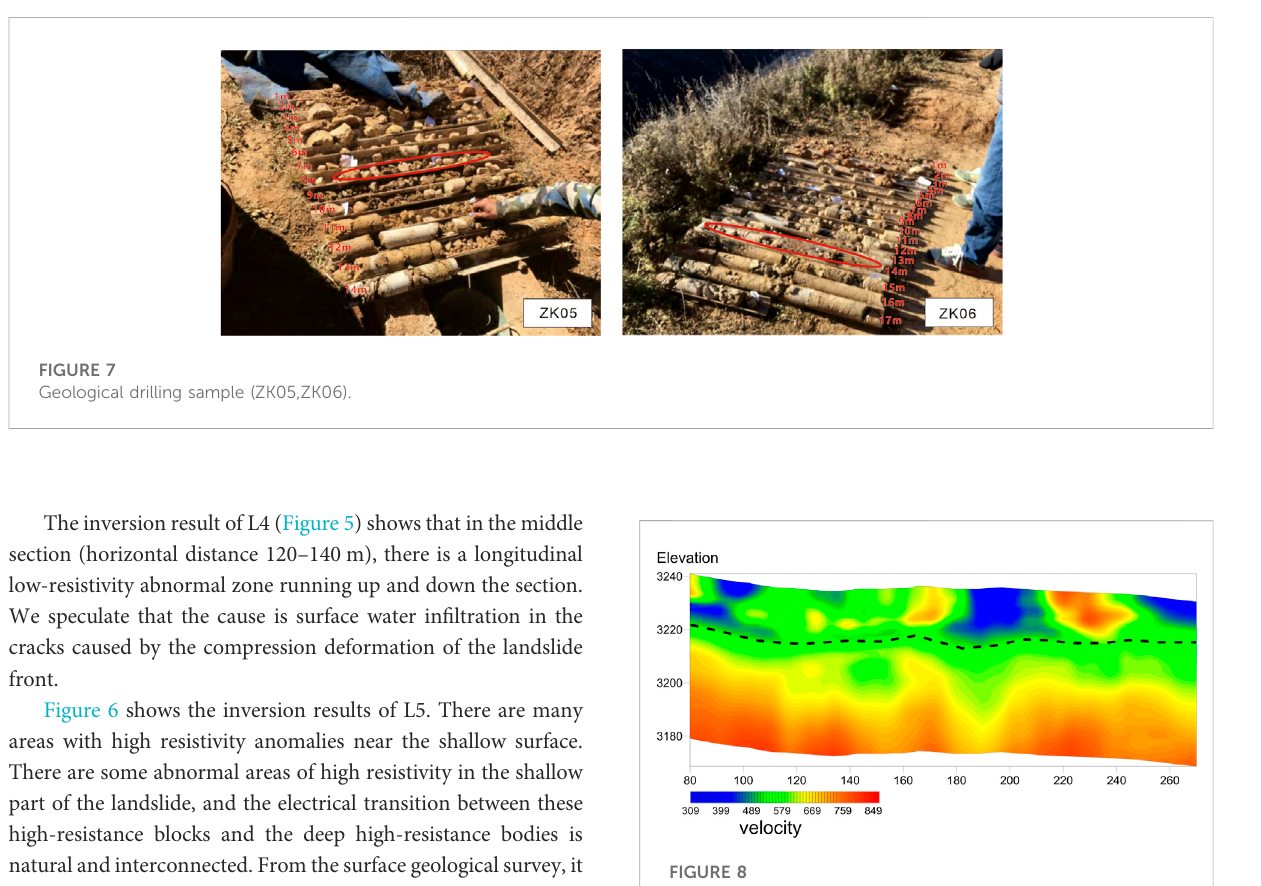
FIGURE 8 Inversion results of MASW survey